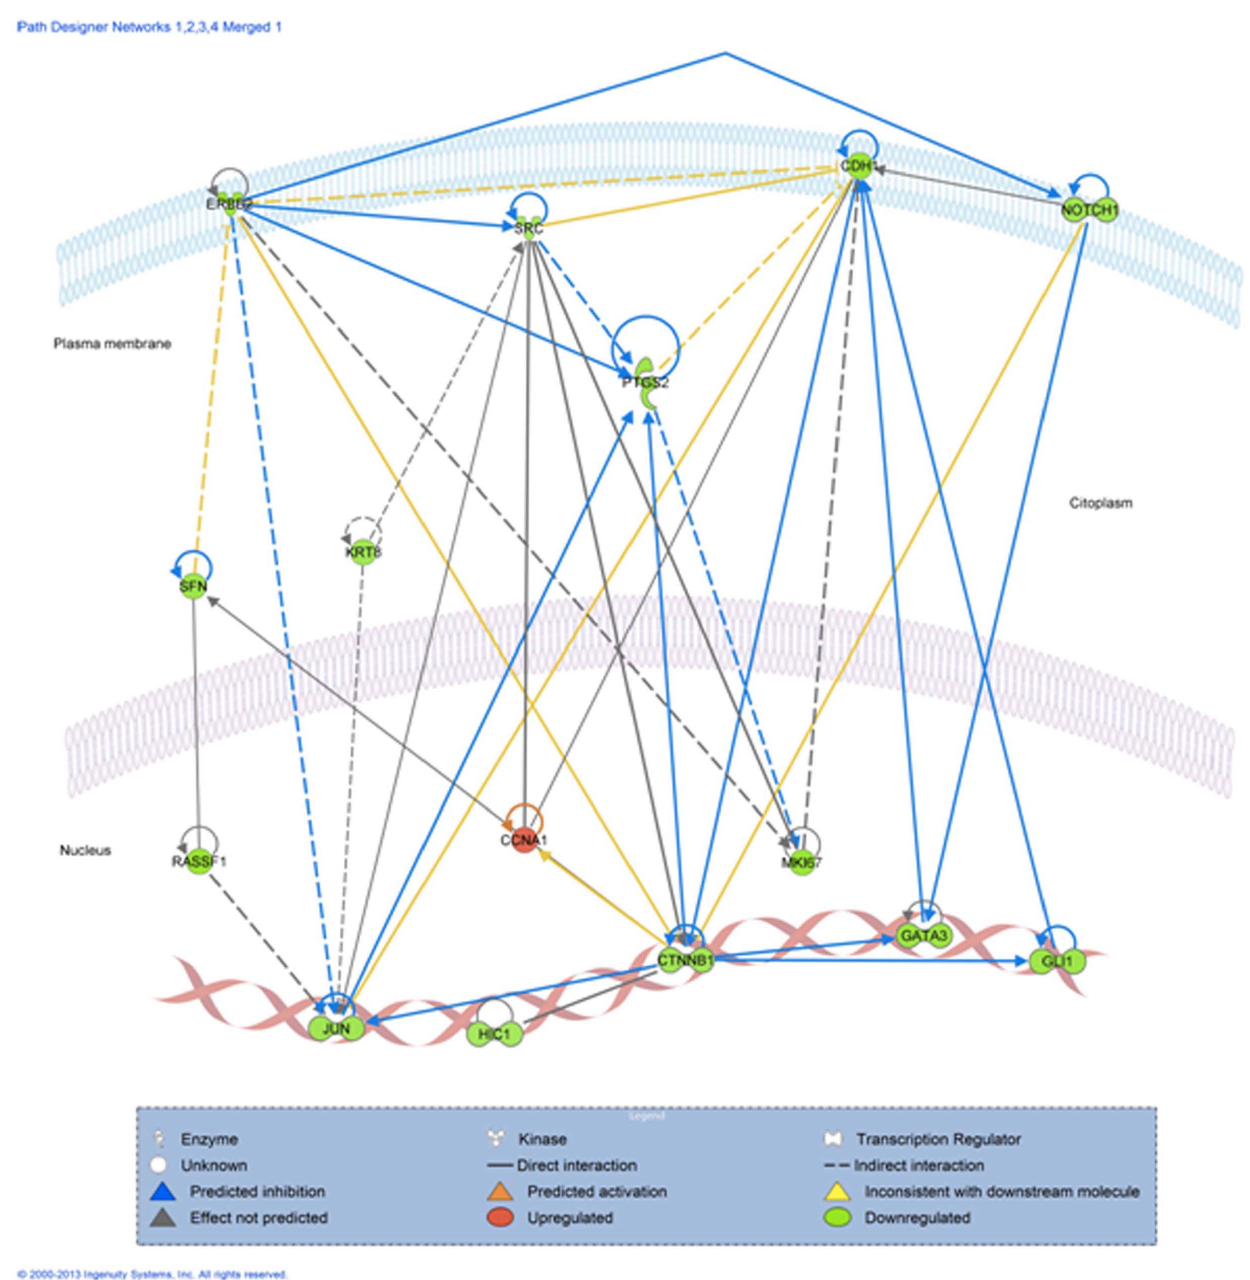
Figure 2. IPA prediction of the interactive network between the differentially expressed genes in the blood of triple negative compared to Her2 + breast cancer patients.